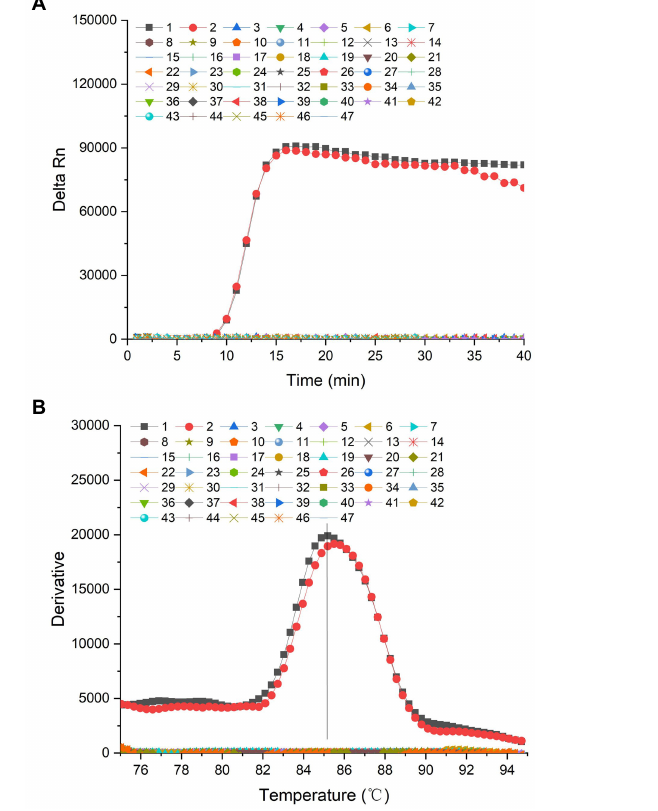
FIGURE 2 (A) Amplification curve of the specificity of the gyrB gene of Pseudomonas lurida . 1: P. lurida CICC22026, 2: P. lurida CICC22027, 3: Pseudomonas fluorescens ATCC13525, 4: P. fluorescens CICC23250, 5: P. fluorescens CICC23251, 6: P. fluorescens CICC23254, 7: Pseudomonas